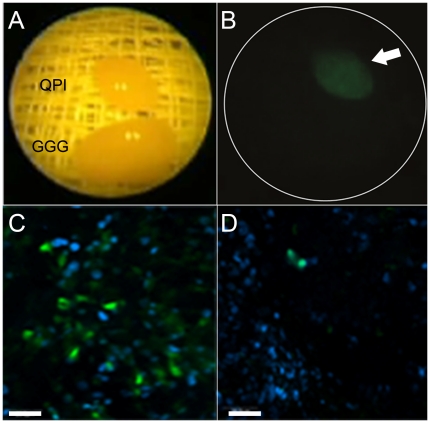
Wide-field and confocal images of excised adenomas incubated with
peptide ex vivo.(A) Two polyps visualized endoscopically ex vivo under
conventional white light illumination. (B) Ex vivo
study shows preferential binding of the fluorescent-labeled target
peptide FITC-Ahx-QPIHPNNM compared to the control peptide
FITC-Ahx-GGGAGGGA
on excised colon. Corresponding representative confocal microscopy
images showing increased binding to the adenoma incubated with (C)
target peptide when compared to (D) the control. A target to control
peptide binding ratio was calculated as 2.51±0.59 (s.d.) for the
excised adenoma pairs. Scale bar, 25 µm.